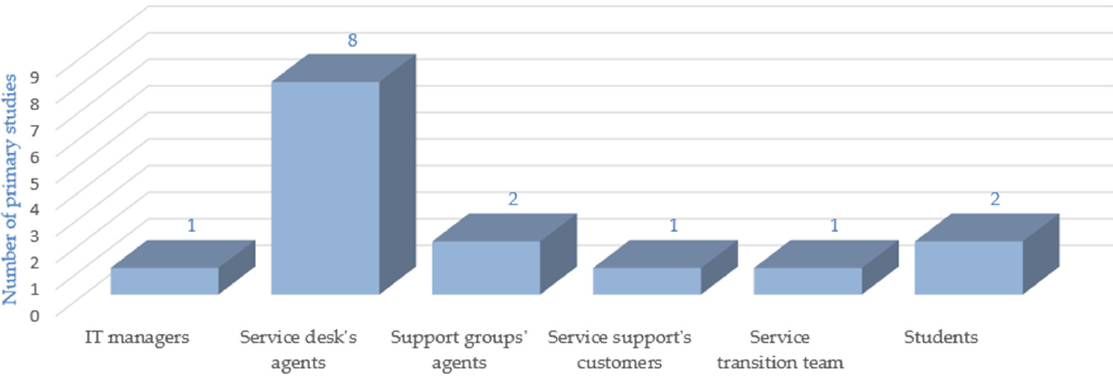
Figure 8. Number of primary studies by participants.